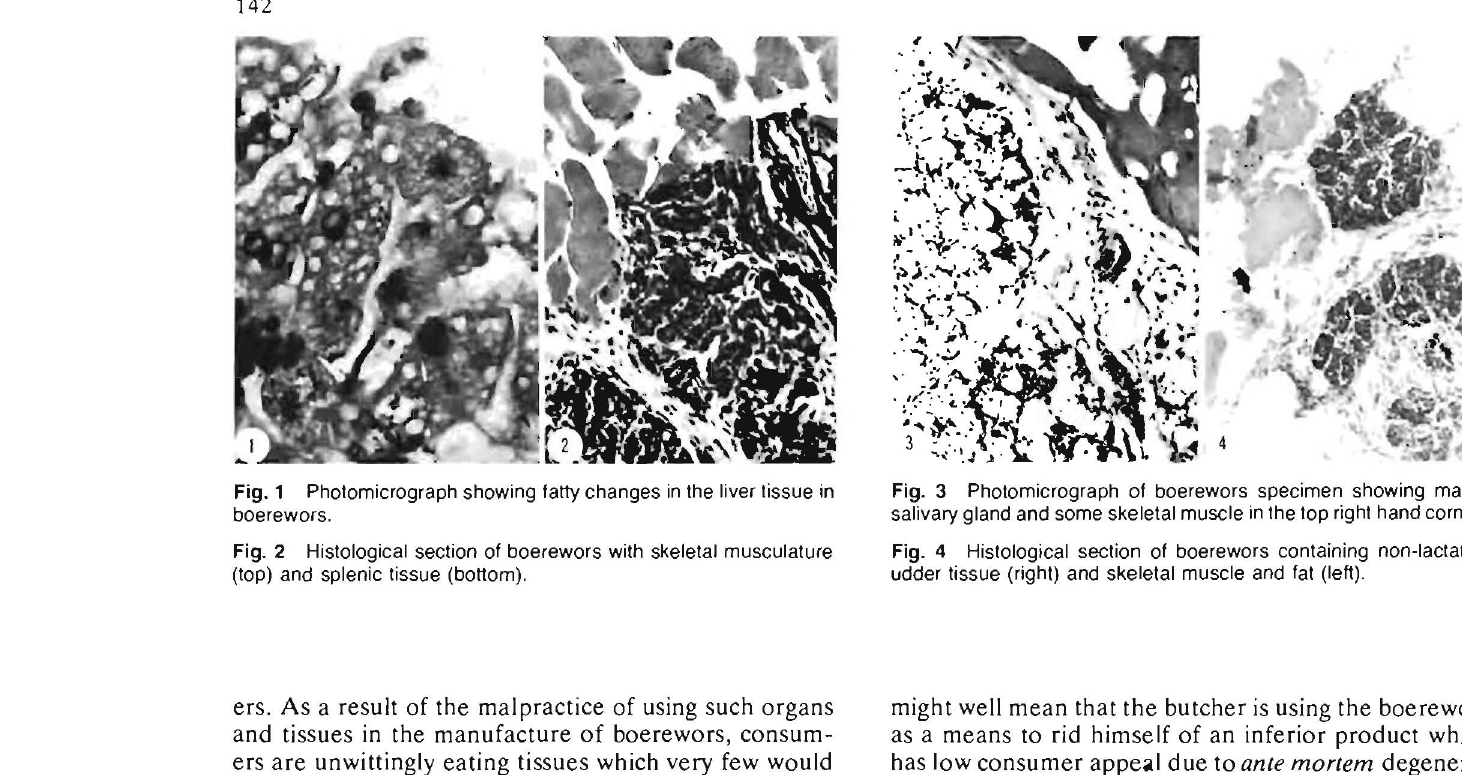
Fig. 3 Photomicrograph of boerewors specimen showing main I' salivary gland and some skeletal muscle in the top right hand corner. Fig. 4 Histological section of boerewors containing non·lactatin! udder tissue (right) and skeletal muscle and fat